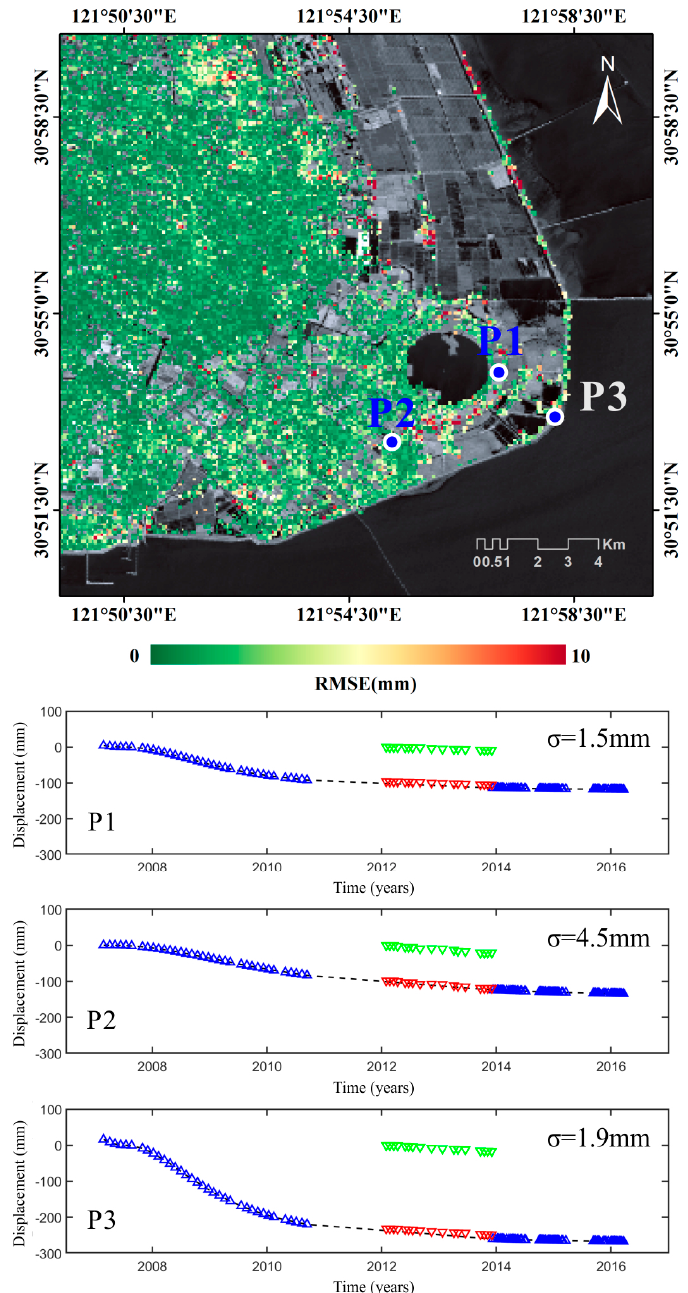
Figure 8. Map of RMSE between the adjusted RST-2 ground-deformation time-series and the combined ENV + CSK ground-deformation time-series at the common coherent points in the area of Lingang New City. The plots of the modeled vertical ENV + CSK deformation time-series (blue triangles), the vertical RST-2 deformation time-series (green triangles) from January 2012 to December 2013, and adjusted vertical RST-2 deformation time-series (red triangles), calculated in correspondence with the three pixels, labeled as P1, P2, and P3, respectively. The σ represents the RMSE between the modeled and adjusted time-series. The cumulative deformation at pixels P1, P2, and P3 is − 118 mm, − 134 mm, and − 267 mm, respectively, from February 2007 to October 2016.